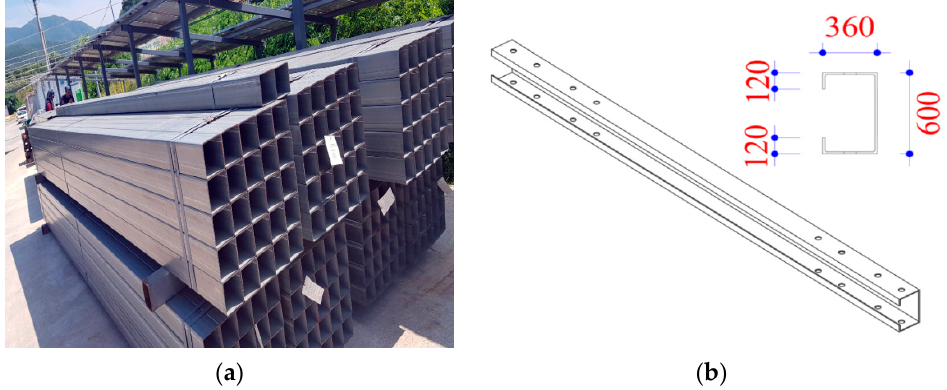
Figure 6. Alloy-plated steel sheet member. ( a ) Shape of alloy plated steel sheet members; ( b ) dimensions of alloy plated steel sheet cross-section (mm).